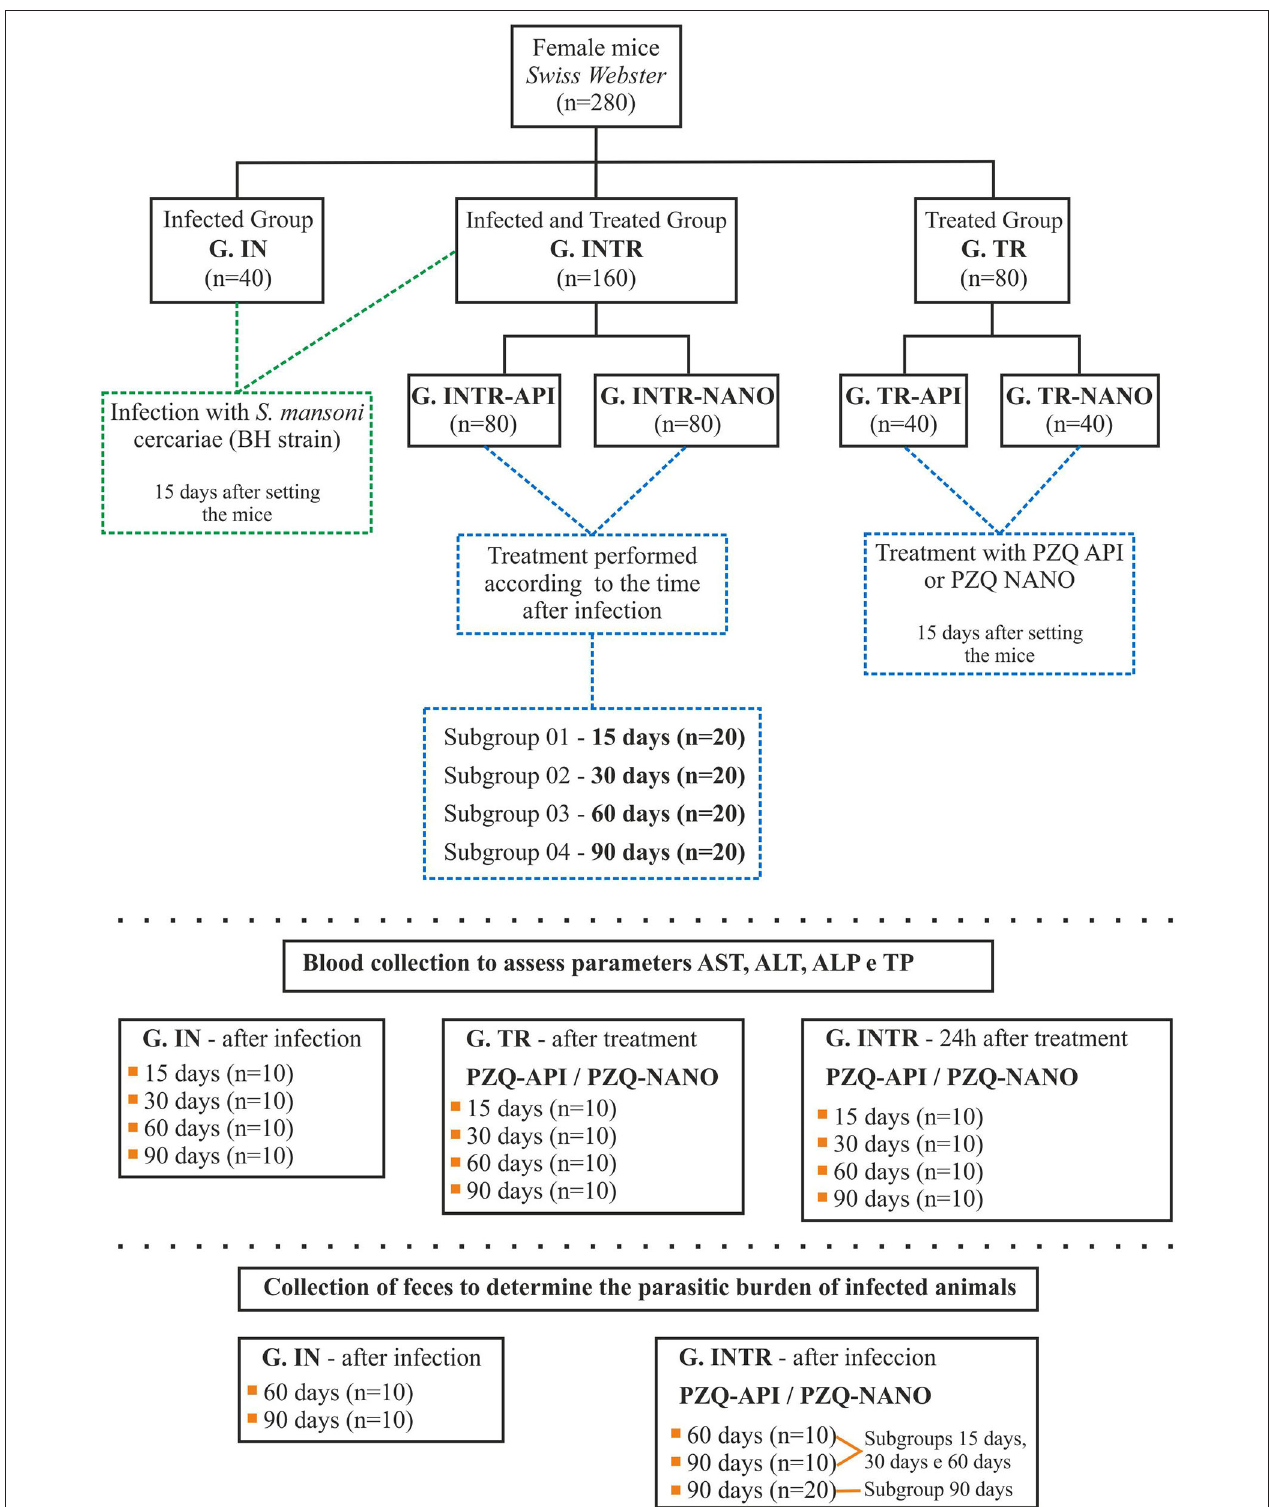
FIGURE 1 | Flowchart of the experimental design of the study.